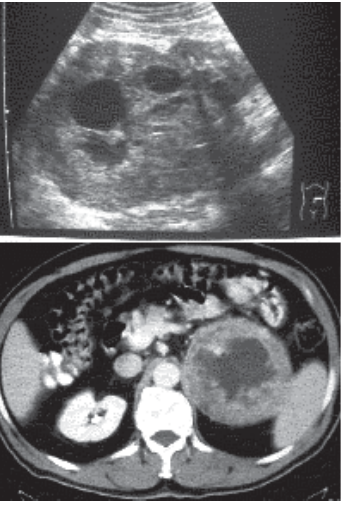
Figure 1-A - Ultrasonography reveals a 12-cm mass on the left flank at adrenal topography with central areas of necrosis and cystic degeneration. B - Computed tomography showing a 12-cm enhancing mass with cystic and necrotic areas arising from the retroperitoneum and displacing the left kidney inferiorly (not shown on this plate)